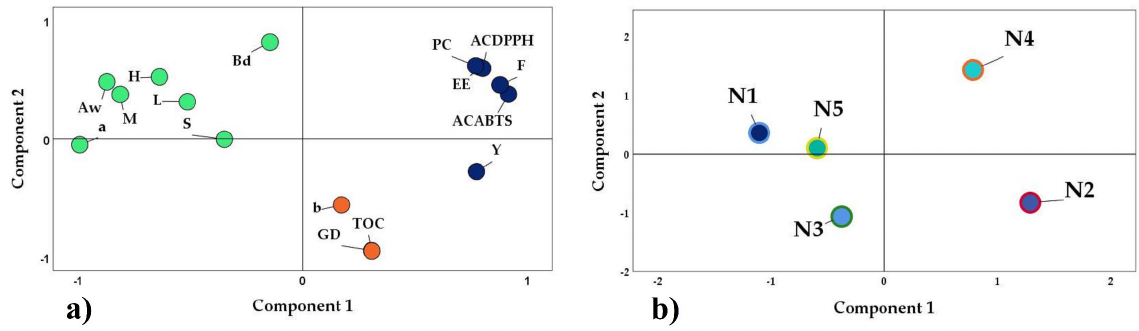
Figure 12. Principal component analysis: a) properties studied and b) nanoencapsulates.